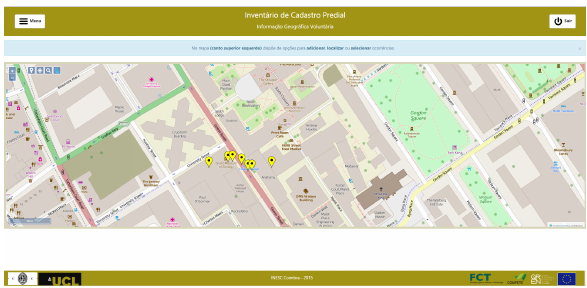
Figure 5: Map view showing existing 3D Cases entered by the user, with Add New button circled